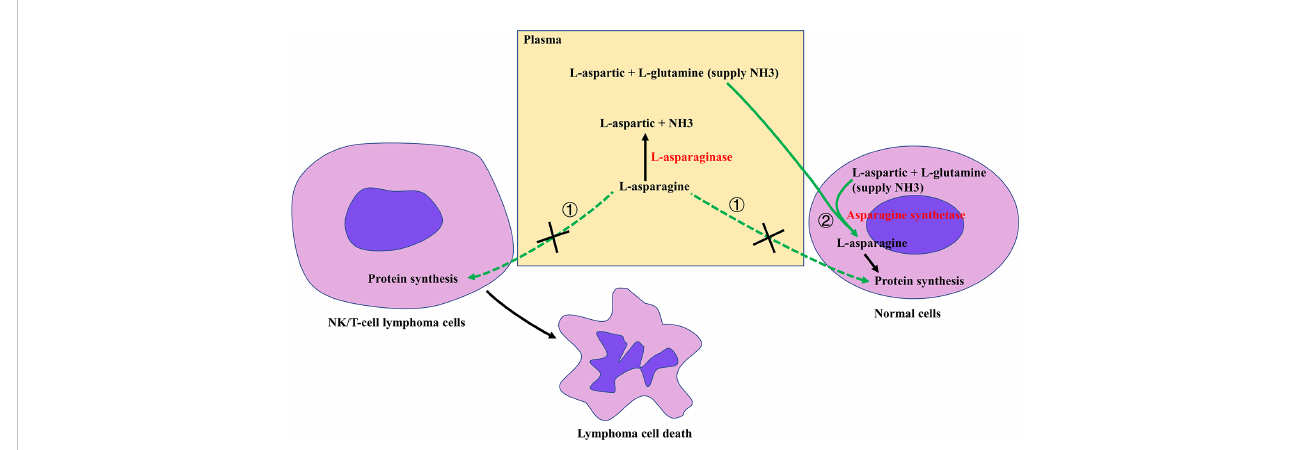
FIGURE 4 Overview of the mechanism of action of asparaginase (Asp) against NK/T-cell lymphoma (NKTCL). Due to the lack of asparagine synthetase (AsnS), NKTCL cells depend on the uptake of extracellular L-asparagine from the circulation (pathway ① ) for protein synthesis. Administration of Asp hydrolyzes serum asparagine to aspartic acid and ammonia (NH3), thereby inhibiting tumor cell protein synthesis and ultimately leading to tumor cell death. In contrast, all normal cells in the body have two pathways to obtain L-asparagine for protein synthesis: taking extracellular L-asparagine from the circulation (pathway ① ) and synthesizing their own L-asparagine from aspartic acid and NH3 via AsnS (pathway ② ). When pathway ① is blocked, normal cells can still obtain adequate L-asparagine via pathway ② to meet their metabolic needs.